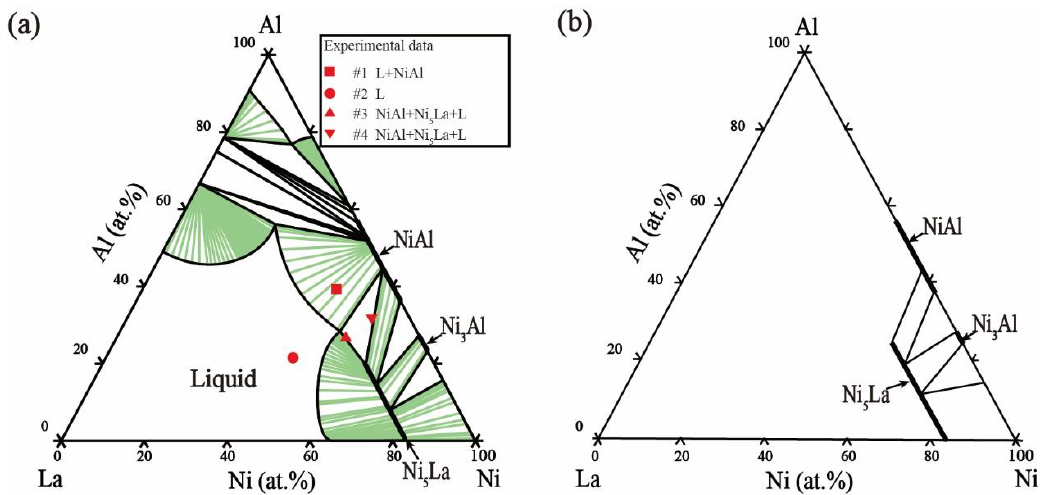
Figure 8. Isothermal section of the Ni – Al – La ternary system at 800 °C. ( a ) Our calculated isothermal section compared with our experimental results, ( b ) literature data [15].